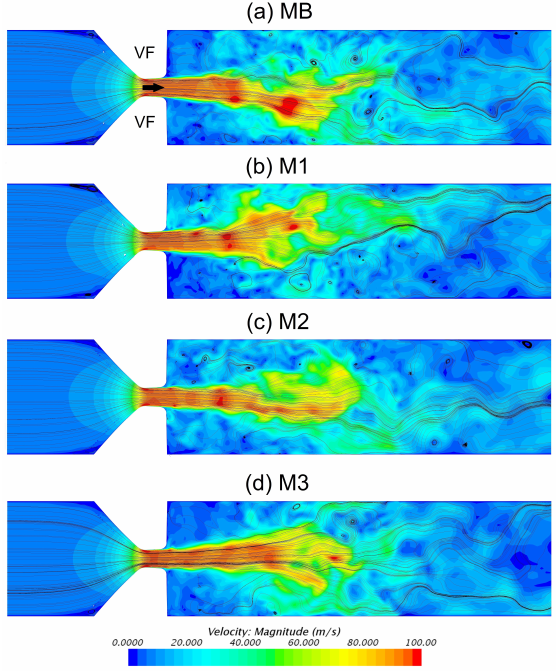
Figure 8. Velocity magnitude contour plots with streamlines in the mid-coronal plane for all mesh resolutions MB-M3 (parts ( a – d )) at the same time instance 0.8T in the oscillation cycle. The arrow shows the flow